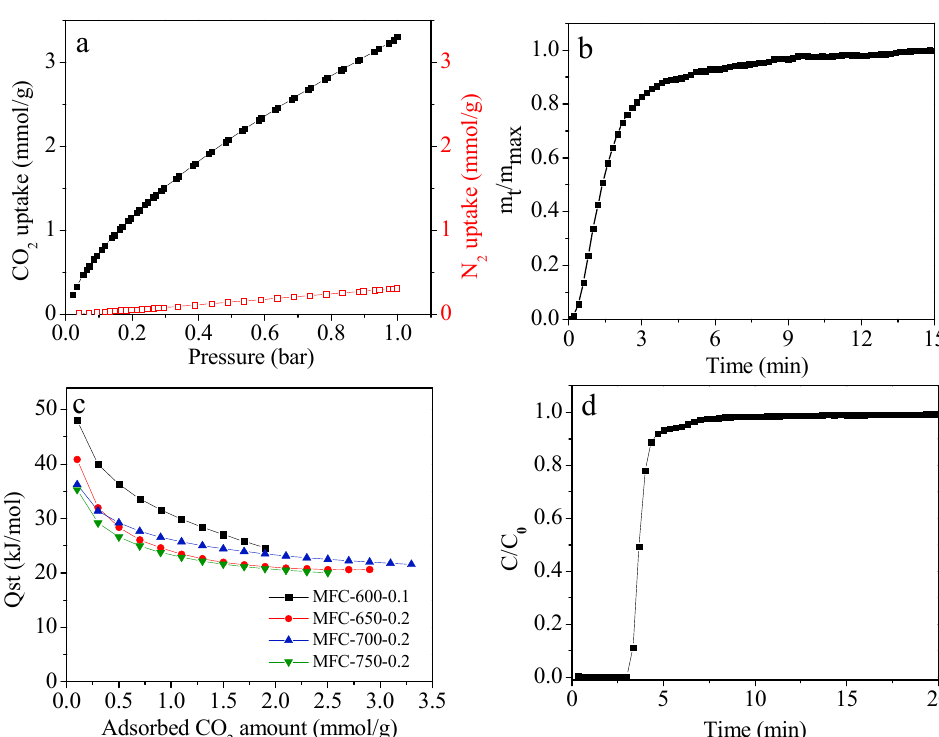
Figure 7. ( a ) CO 2 and N 2 adsorption isotherms of MFC-700-0.2 at 25 °C and 1 bar, the black line is CO 2 isotherm and the red line is N 2 isotherm ( b ) CO 2 adsorption kinetics at 25 °C for MFC-700-0.2, ( c ) Qst (isosteric heats of adsorption) on selected sorbents and ( d ) breakthrough curves of MFC-700-0.2. Adsorption conditions: gas pressure = 1 bar, adsorption temperature = 25 °C, gas flow rate = 10 mL/min, inlet CO 2 concentration = 10 vol.%.